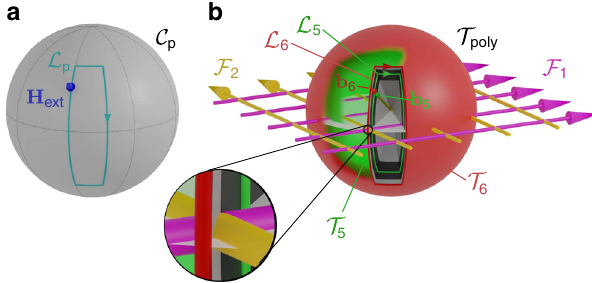
Fig. 3 Control and transcription spaces. a Polydirectional control space C p . Each point on the sphere represents the orientation of the external fi eld. Commands are given as closed loops L p . b Polydirectional transcription contains all unidirectional transcription spaces T n that are space T poly concentric spheres of radius b n . Each point in T n represents the orientation of a biped of length b n . One point in C p is transcripted into a ray in T poly . The unidirectional loops L 5 (green) and L 6 (red) wind around different fence lines and they pass on different sides of the (pink) F 1 - and (yellow) F 2 -line as can be seen in the magni fi